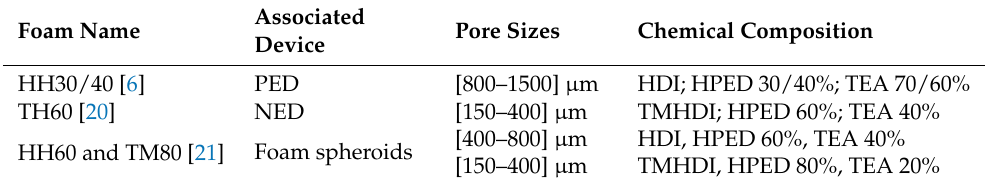
Table 2. SMP Foams with identifying chemistry, pore size, and associated